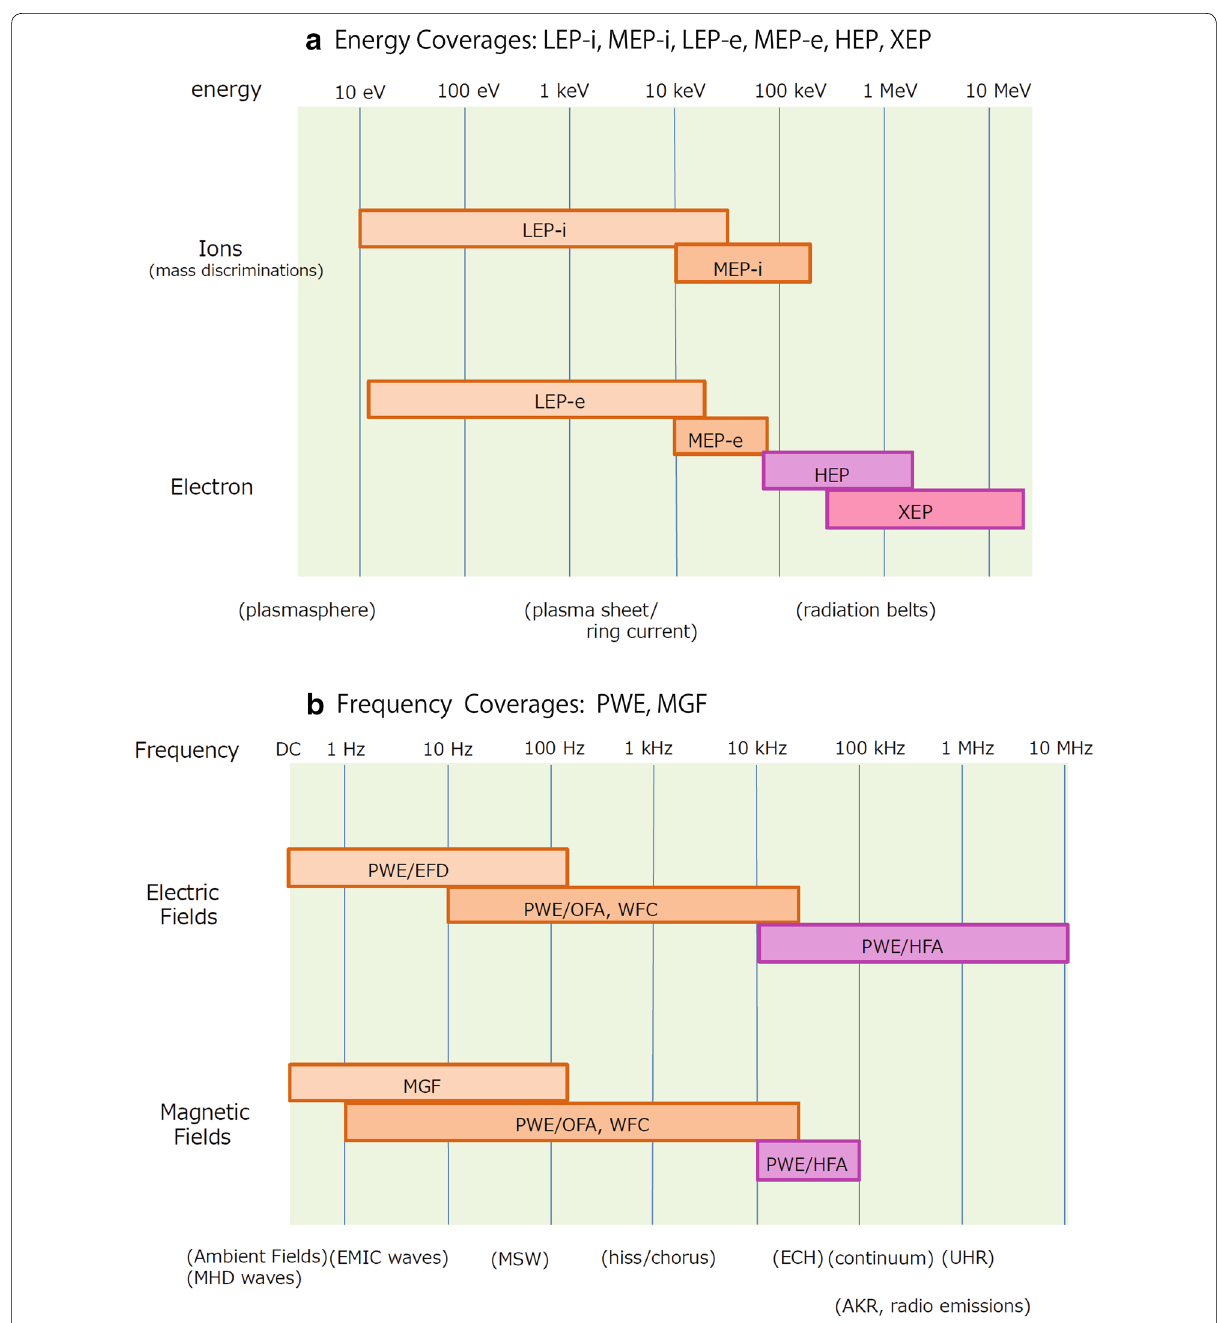
Fig. 5 a Energy coverage of electron measurements from LEP‑e, MEP‑e, HEP, and XEP, and ion measurements from LEP‑i and MEP‑i. b Frequency coverage of electric field and magnetic field measurements from PWE (EFD, OFA/WFC, HFA) and